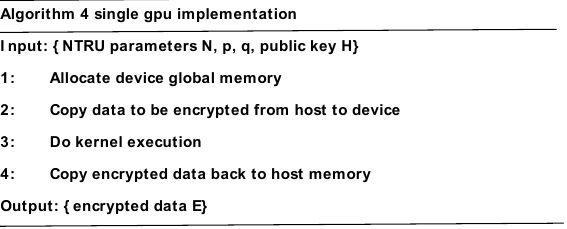
Algorithm 4 single gpu implementation